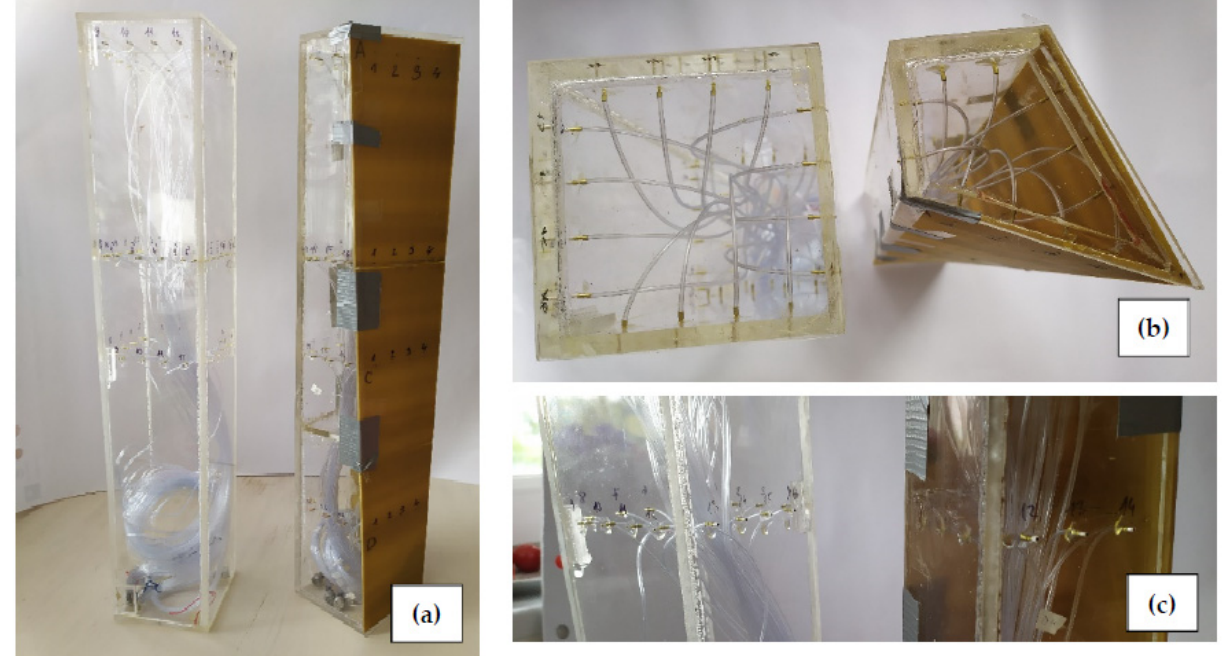
Figure 4. ( a ) The reduced-scale models; ( b ) the roofs in detail; ( c ) measuring taps in detail.